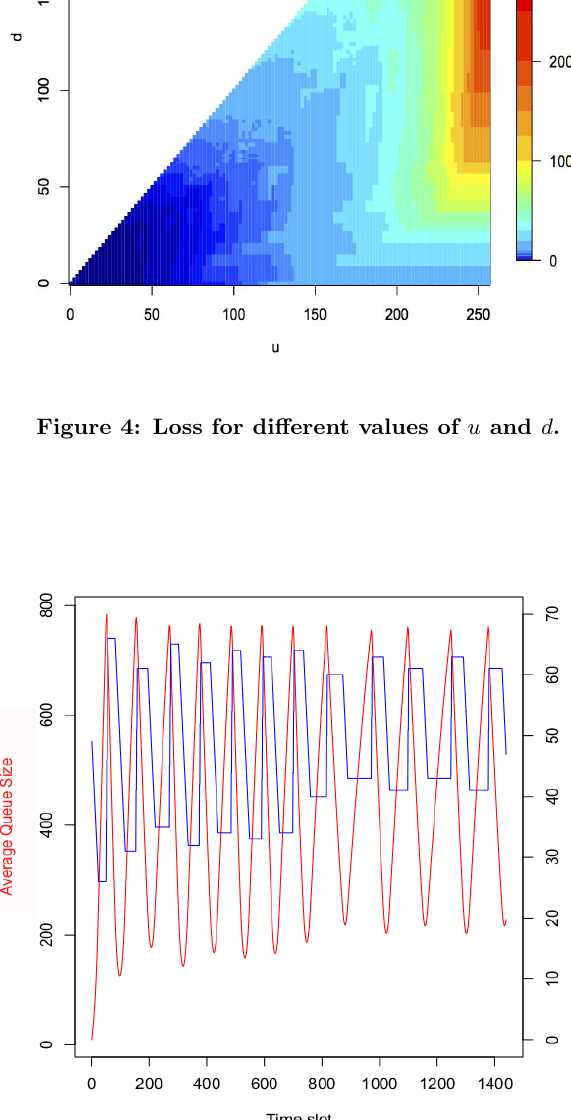
Figure 5: The evolution of the number of oper- ational servers (blue) and the average queue size